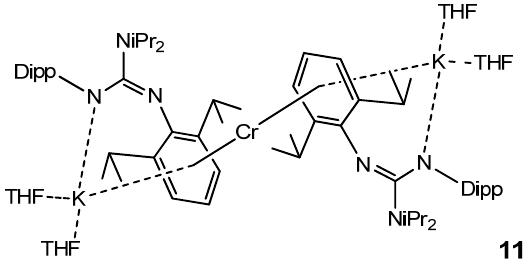
Figure 7. Monomeric chromium (0) bimetallic complex.